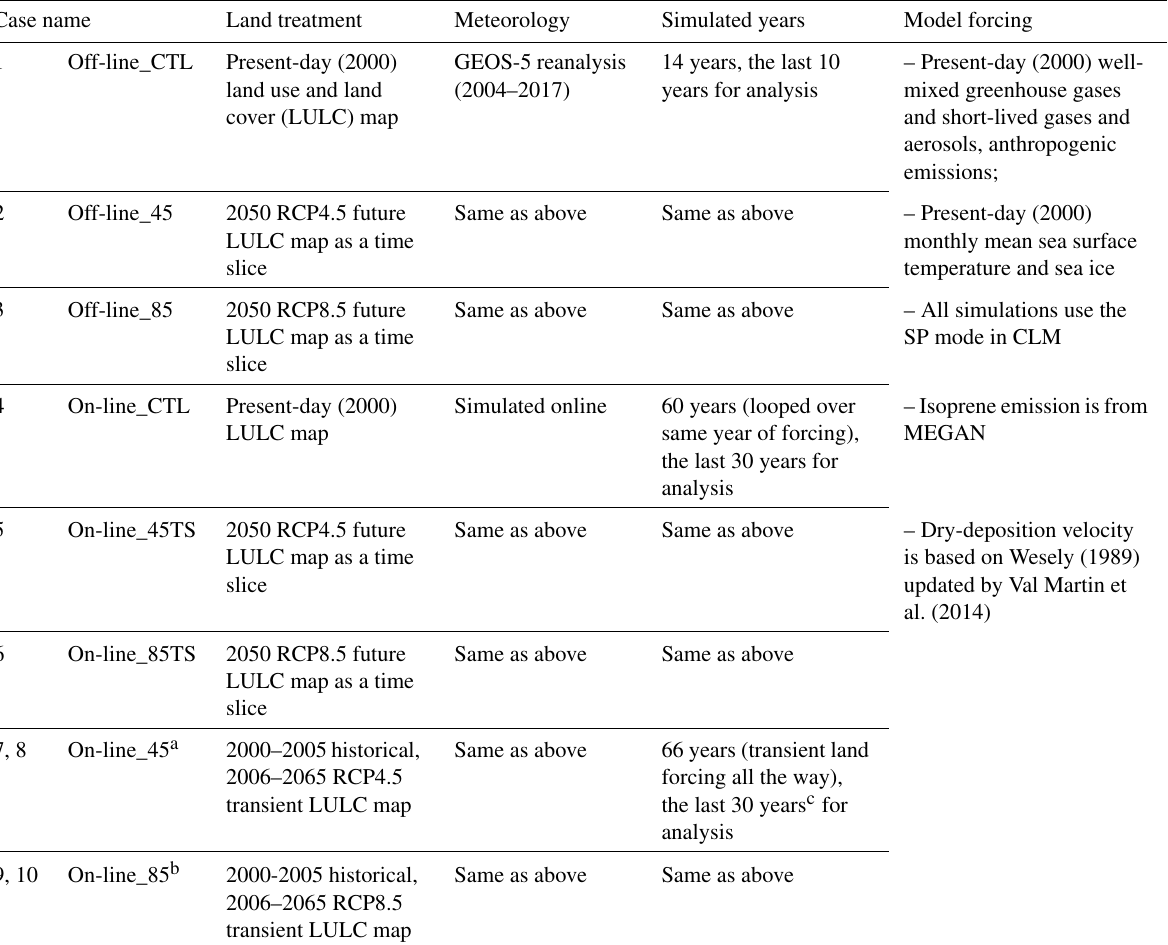
Table 1. List of model